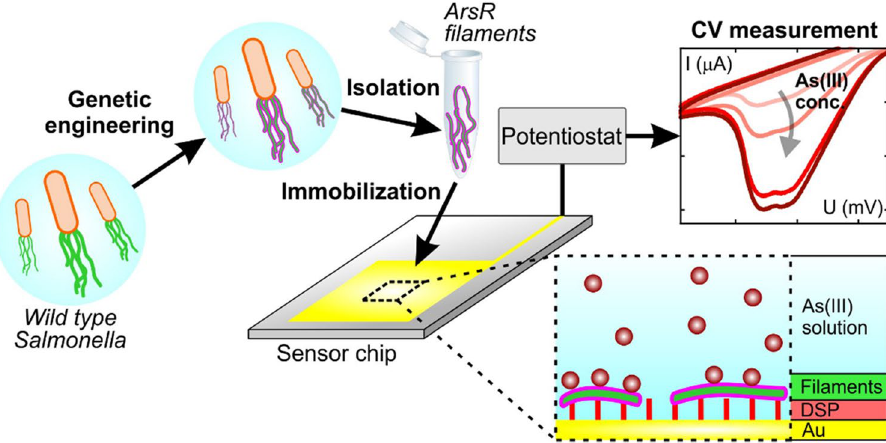
Figure 1. Schematic illustration of our As(III) detection methodology presented in this study. The workflow shows the production of genetically engineered flagellar filaments, their deposition on the gold working electrode surface as well as CV measurements on sample solutions containing As(III) at different